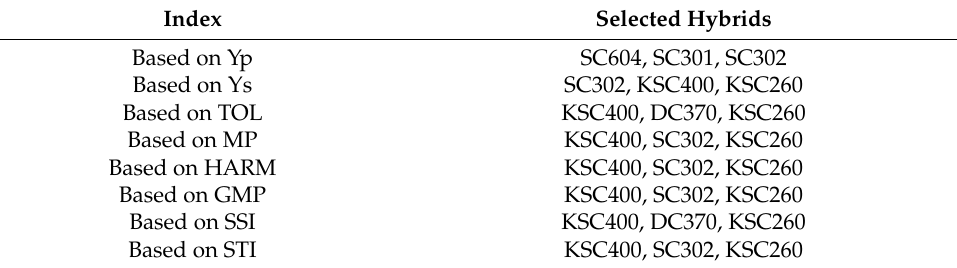
Table 5. Selected hybrids based on drought-tolerance